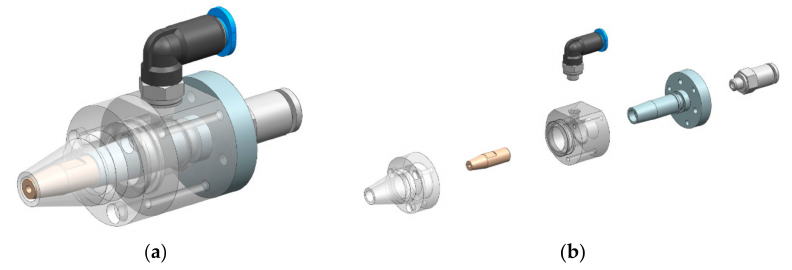
Figure 1. ( a ) New nozzle solution assembly; ( b ) exploded diagram of the nozzle.